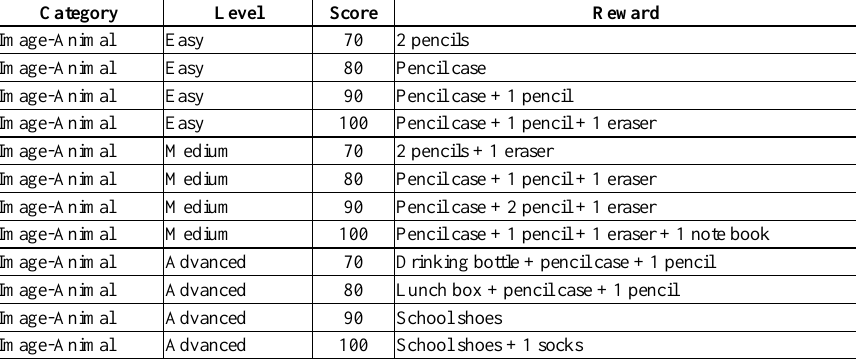
Table 1. Tabel Scores and